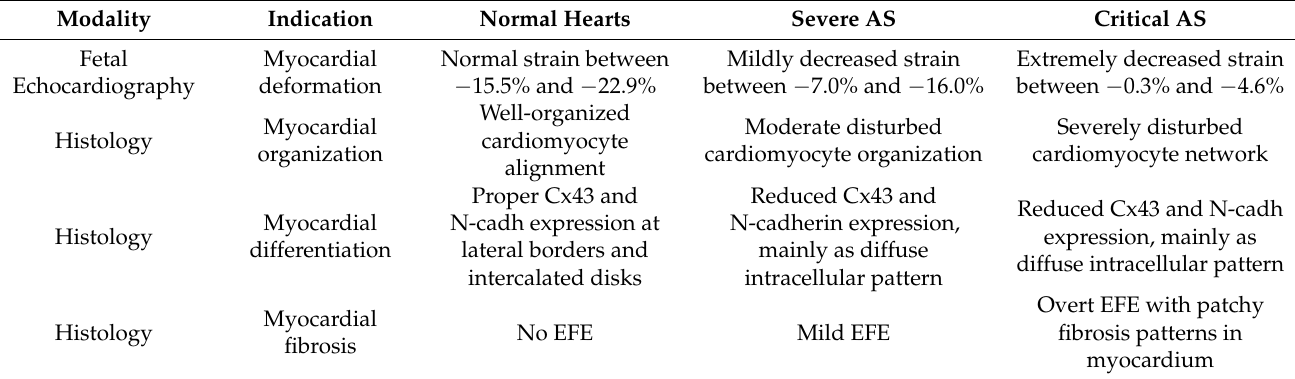
Table 4. Summary of main ultrasound and histological findings (left